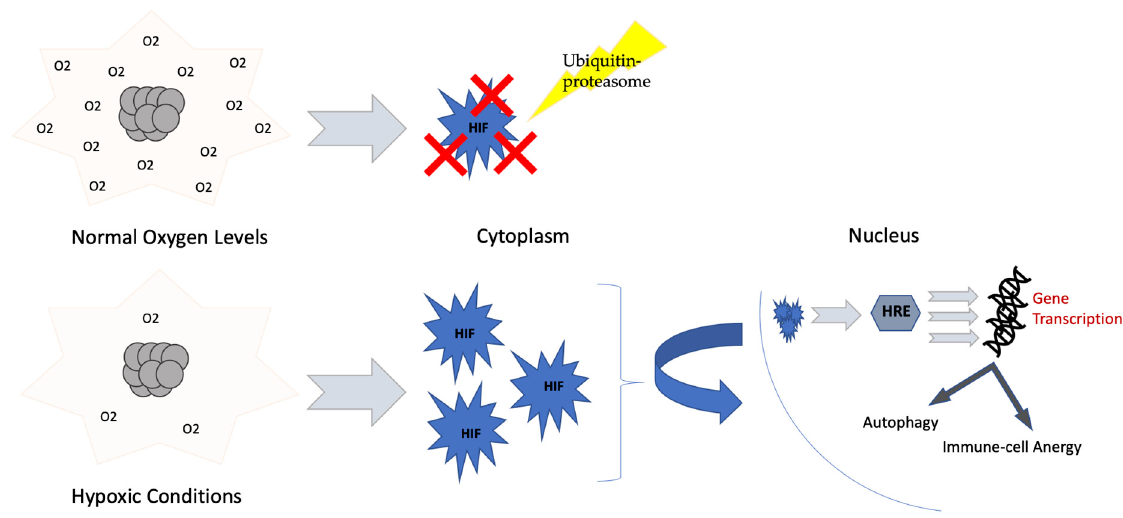
Figure 4. Hypoxia and HIF-1 α . In normal oxygen levels, HIF-1 α is rapidly degraded by the ubiquitin-proteasome system. With hypoxia, HIF-1 α accumulates in the cytoplasm, and is translocated to the nucleus, where it forms the hypoxia-responsive element (HRE) responsible for the transcription of genes involved in various cellular pathways, including autophagy as well as immune-cell anergy [78].